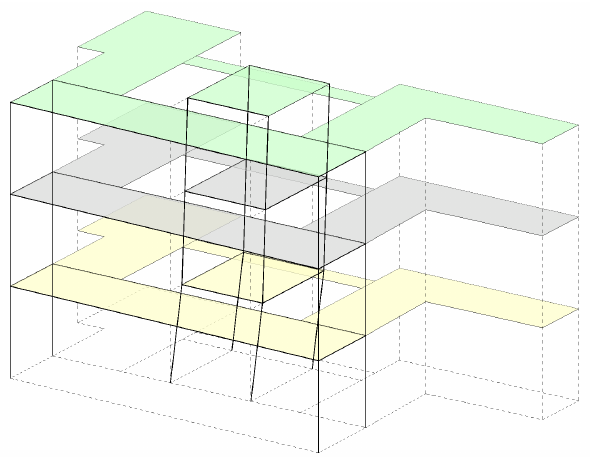
Figure 7. Translational mode in direction